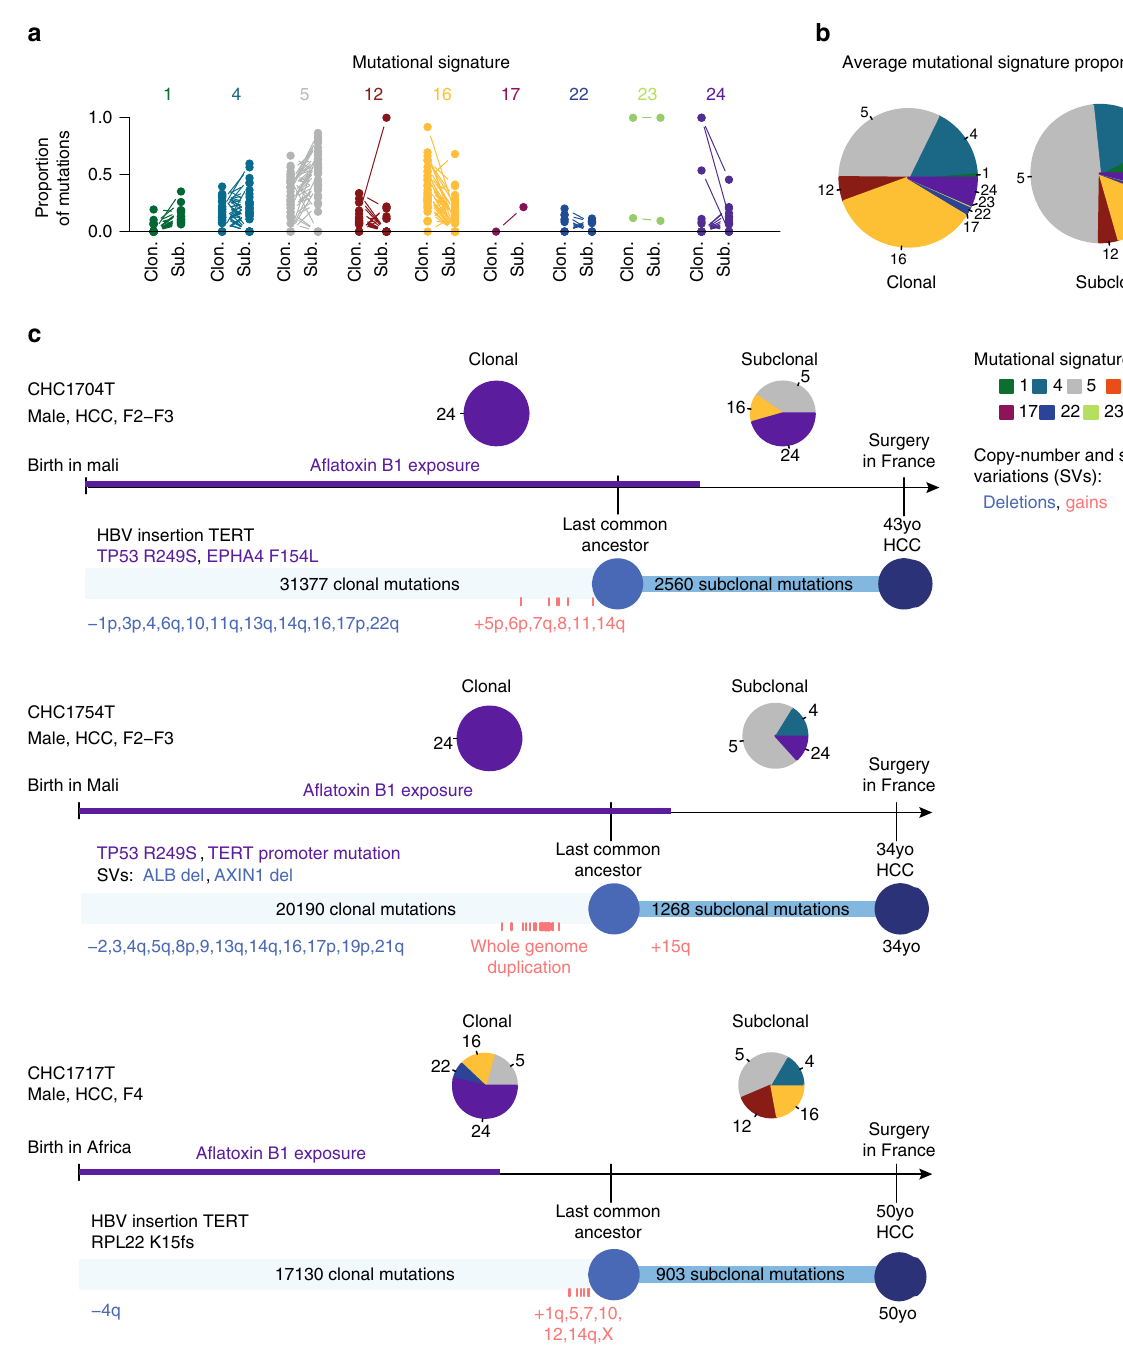
Fig. 5 Mutational processes evolve along liver tumorigenesis. a Proportion of mutations attributed to each mutational signature in the clonal and subclonal mutations of each tumor (connected with a line). Clon. clonal; Sub. subclonal. b Average contribution of each signature to clonal and subclonal mutations in our series of 44 liver tumors. c Clonal history of 3 HCC developed in African migrants with a fl atoxin B1 exposure and HBV infection. Driver alterations in the clonal and subclonal compartments are indicated with a color code describing the type of event and the most likely signature of origin, as represented in the legend. The R249s mutation of TP53 , hallmark of a fl atoxin B1 exposure, is encountered in two patients. TERT promoter is altered by mutation in one patient and HBV insertion in two patients. The two TP53 -mutated tumors display many chromosome deletions, and the 3 cases show an accumulation of chromosome gains shortly before the last selective sweep. Signature 24 (a fl atoxin B1) is dominant in clonal mutations but vanishes in subclonal